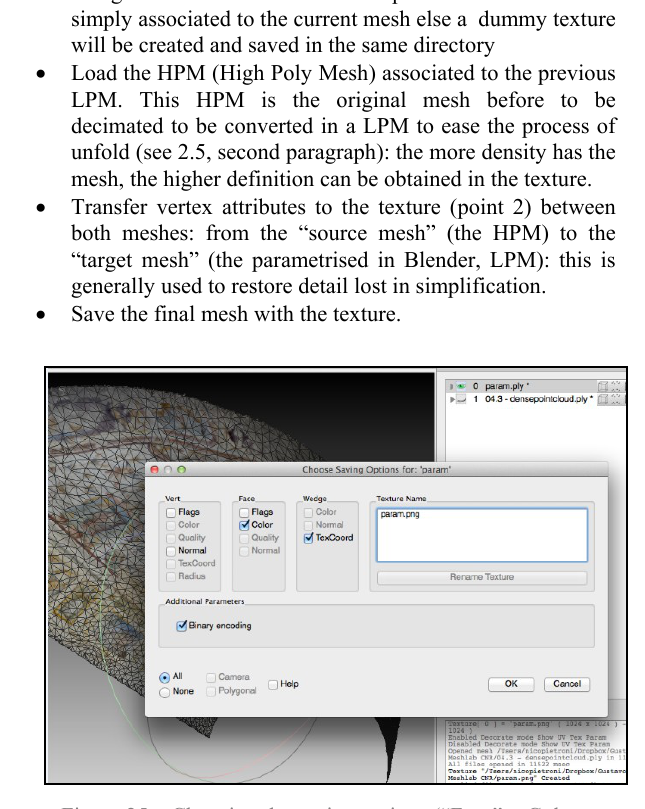
Figure 25 – Choosing the saving options (“Face” = Color, “Wedge” = TexCoord) to obtain the textured unfold